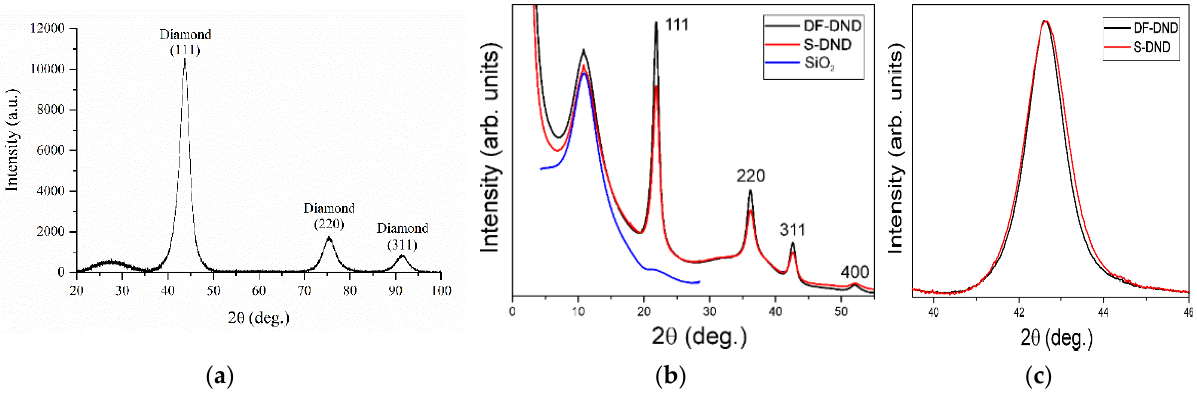
Figure 3. X-ray diffraction patterns: ( a ) S-DNDs at Rigaku SmartLab III; background is subtracted. ( b ) ESRF ID28 data for DF-DNDs and S-DNDs composed of three sets corresponding to three positions of the 2D detector; empty capillary scattering is shown. ( c ) Close-up of the 311 peak with the subtracted background and peak rescaling.